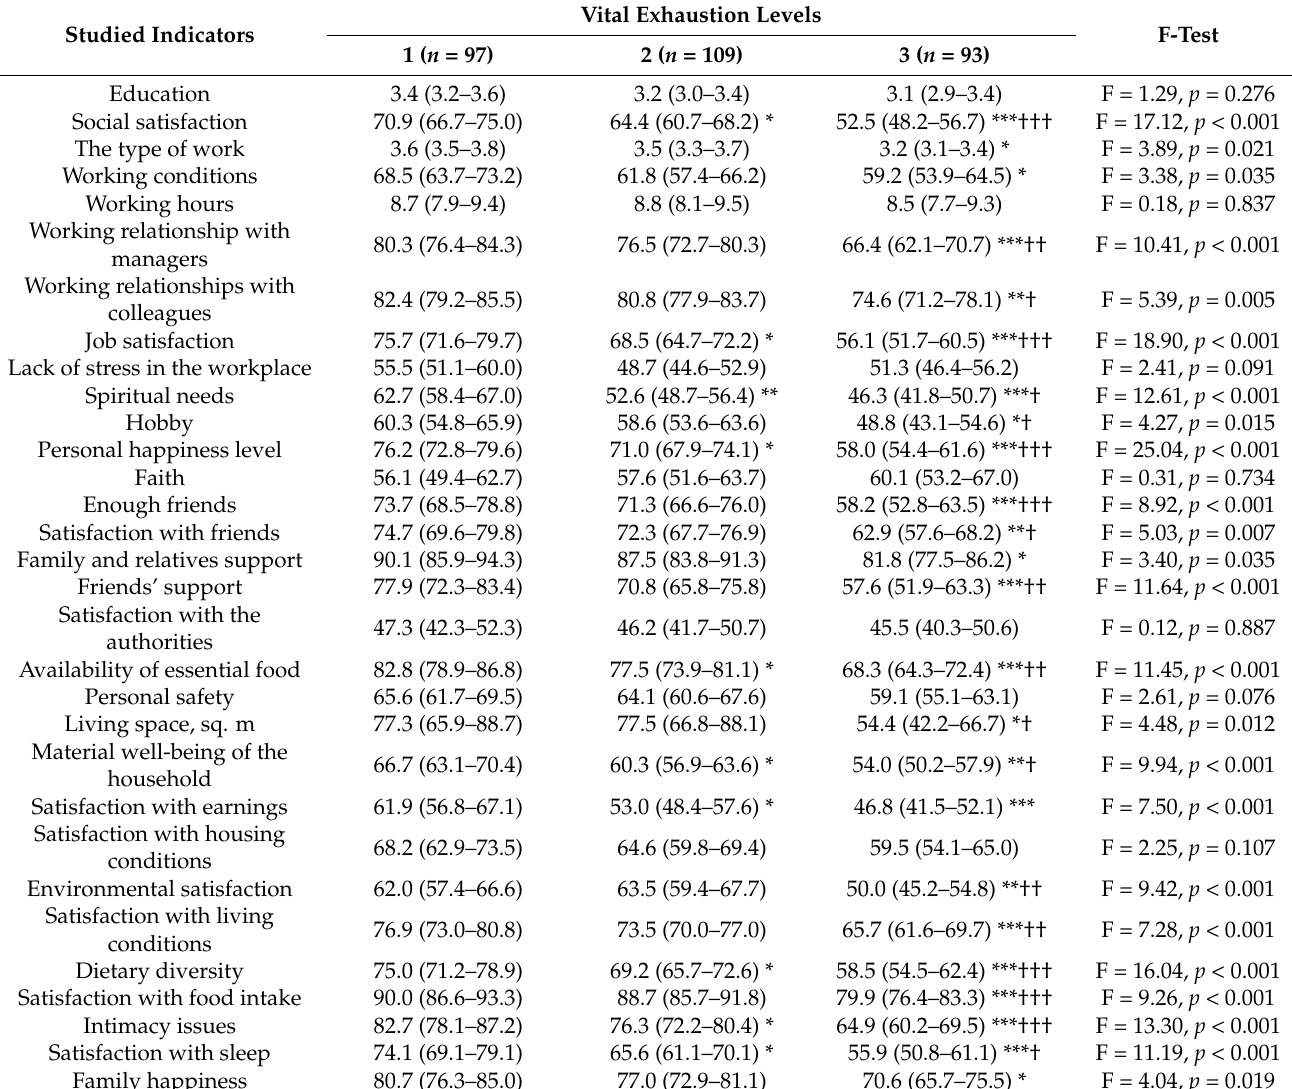
Table 5. Comparative analysis of indicators of psychosocial environment and lifestyle in groups of males with different vital exhaustion levels after the correction for the psychosocial stress